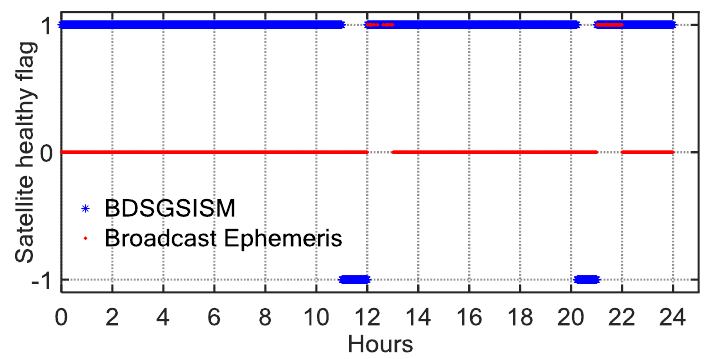
Figure 10. Satellite-health flag as a function of BDT, determined using two methods (blue *, BDS Ground SIS Monitoring (BDSGSISM); red dots, broadcast ephemeris) on day 346 of 2015 for BDS satellite C02.